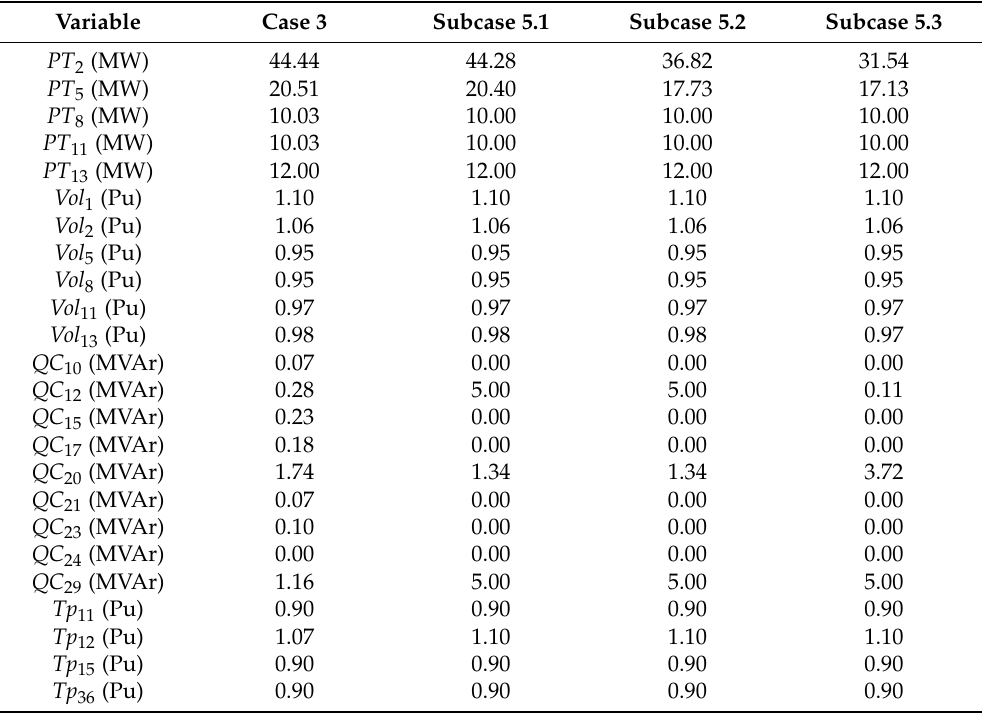
Table A3. Optimal solutions obtained by JSA for study cases with the placement of wind turbines and the consideration of electric